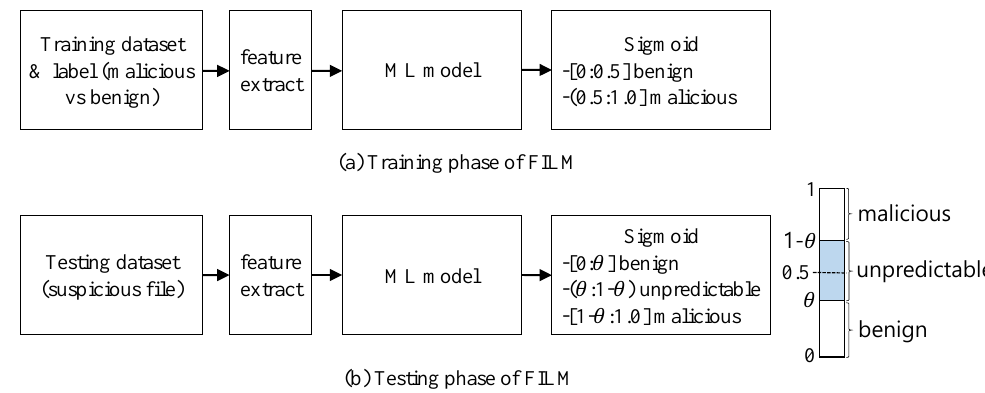
Figure 3. Training and testing phases of FILM. A sigmoid function is appended to an existing ML model. During the testing phase, the sigmoid value is interpreted in three